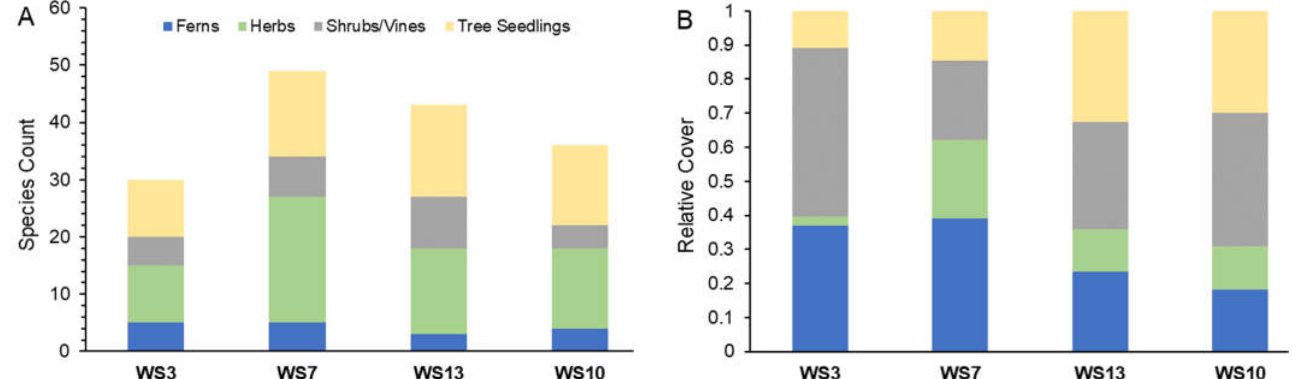
Figure 3. Species count ( A ) and the proportion of overall cover ( B ) by herb-layer plant type at the watershed level for the Summer 2018 sampling. Note that watersheds (WS) are arranged on the x -axis so that those analyzed as a pair (Table 2) are adjacent to each other. Data are from the Fernow Experimental Forest, West Virginia, USA.